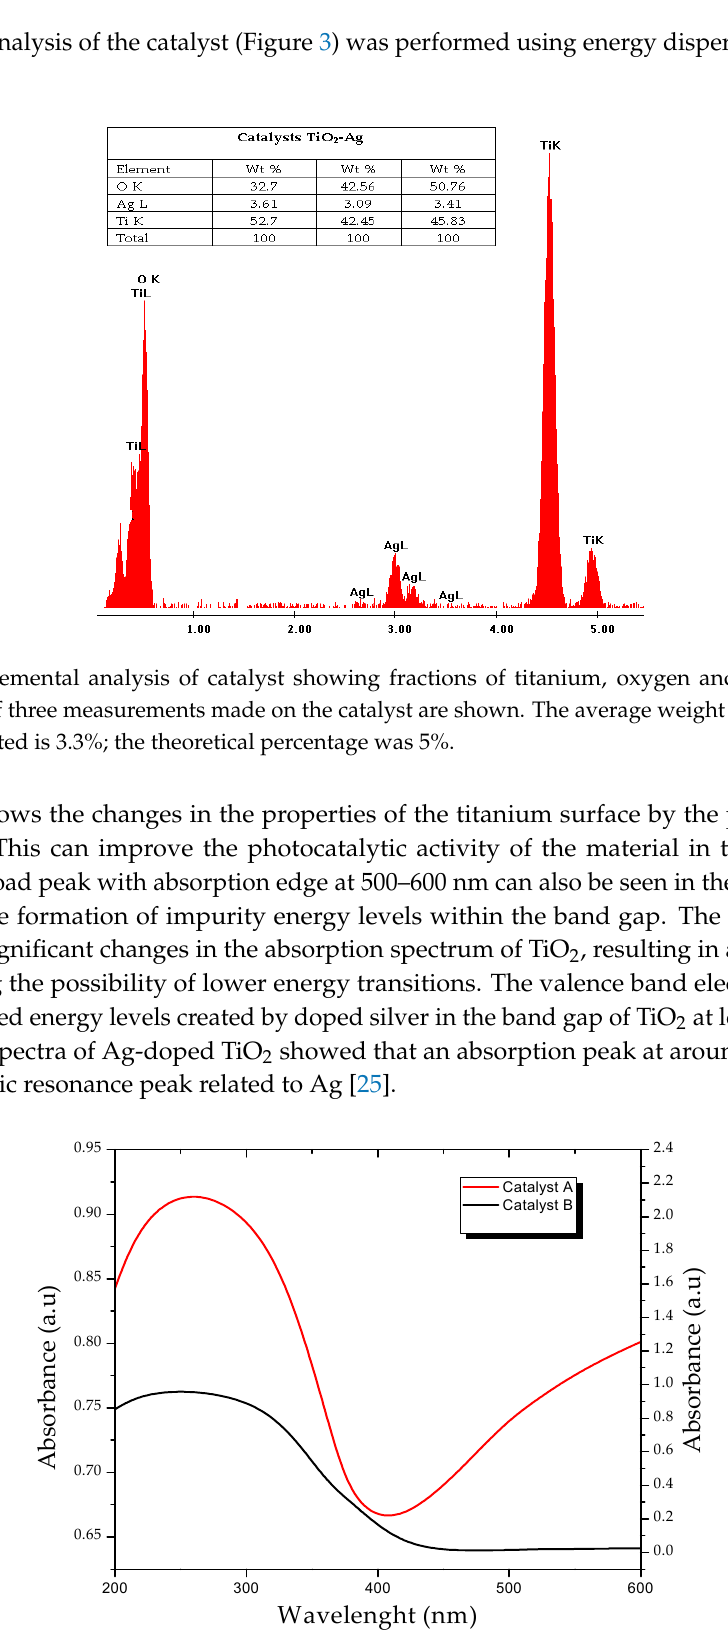
Figure 4. Comparison of the diffuse reflactance spectrum of the commercial catalyst TiO 2 ( B ) with the catalyst modified with nano-silver particles ( A ).